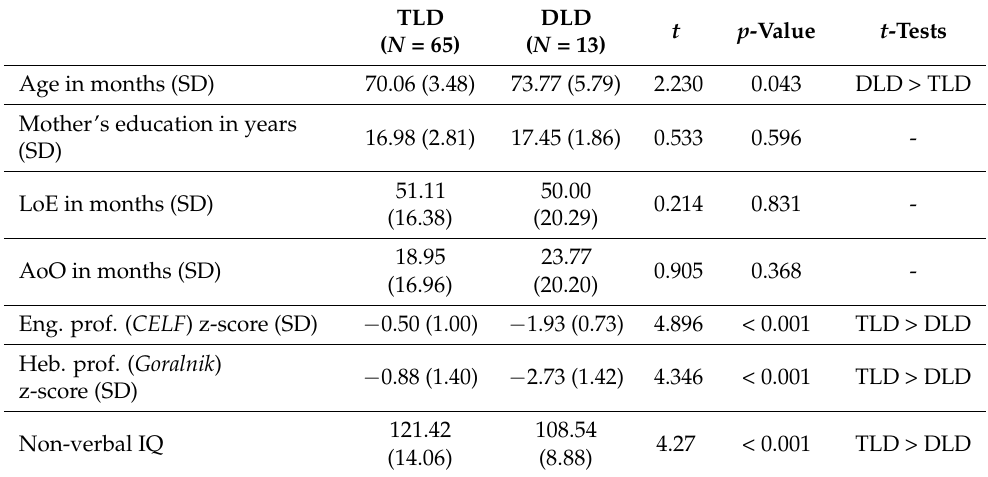
Table 1. Demographic, exposure (LoE, AoO), proficiency and other background data from children with TLD and